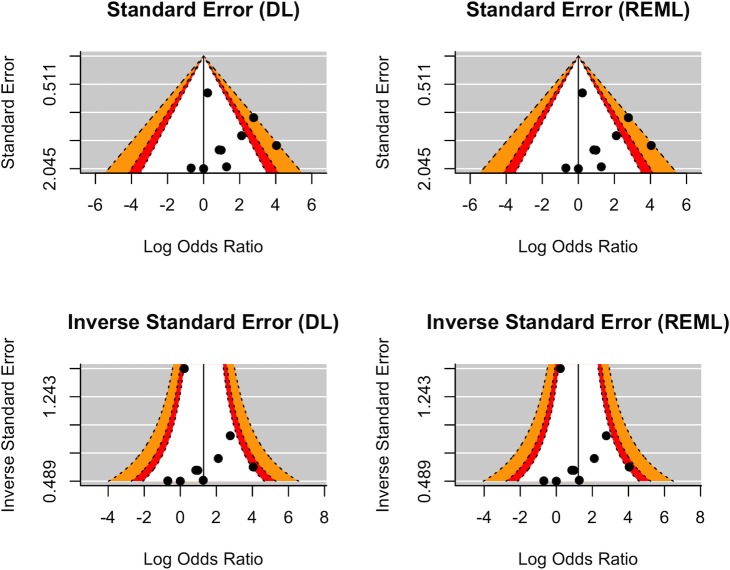
Sensitivity of the relationship between MD and CMV-infection to leave-one-out analyses.The overall effect size(s) obtained by omitting any particular study is indicated in a descending (non-cumulative) manner, with the study omitted indicated on the y-axis by (¬), and the respective effect sizes (log(OR)) presented along with 95% C.I. on the RHS. The overall effect obtained prior to the omission of any study is indicated by the bottommost light grey diamond. A: Sensitivity analysis (DL). B: Sensitivity analysis (REML).